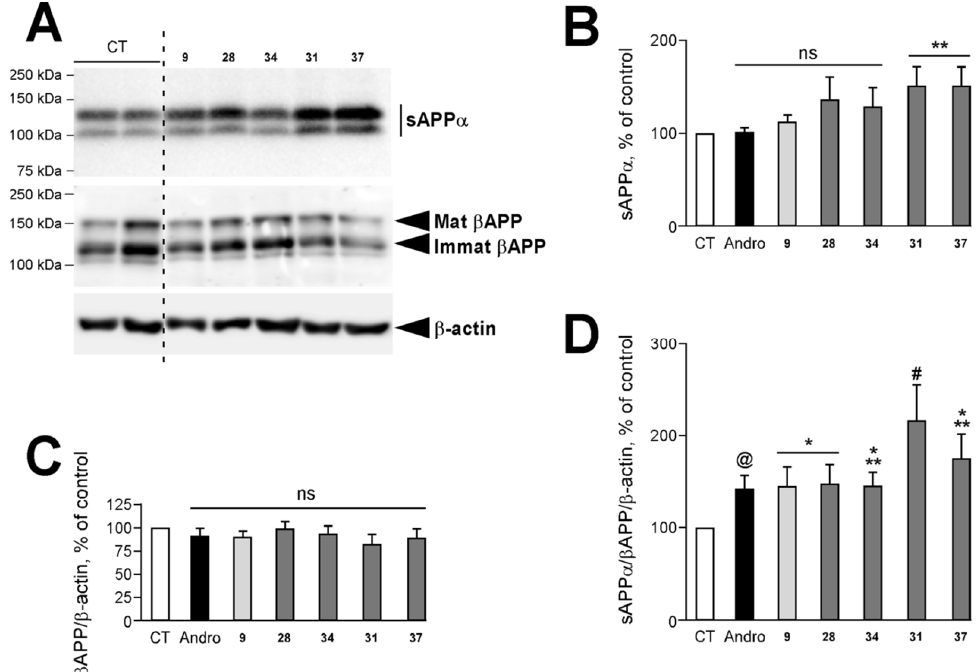
Figure 2. Effect of andrographolide and the selected andrographolide derivatives on sAPP α secretion, β APP protein levels and the ratio sAPP α / β APP in SH-SY5Y cells. ( A ) illustrates one representative gel. Bars in ( B ) (sAPP α production), ( C ) ( β APP immunoreactivity normalized with β -actin), and ( D ) (ratio of sAPP α to β APP normalized with β -actin) correspond to the densitometric analyses, are expressed as a percentage of control (white bars, non-treated cells), and are the means ± SE of 6 to 10 independent determinations. * p < 0.05; ** p < 0.03; *** p < 0.02; # p < 0.01; @ p < 0.001; ns, no statistical difference. The hatched black line in (A) indicates a splicing of the original